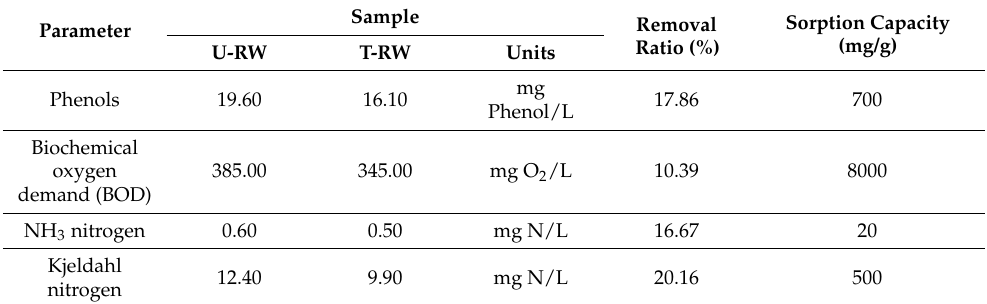
Table 2. Characterization of the large volume samples of real wastewater treated with the developed